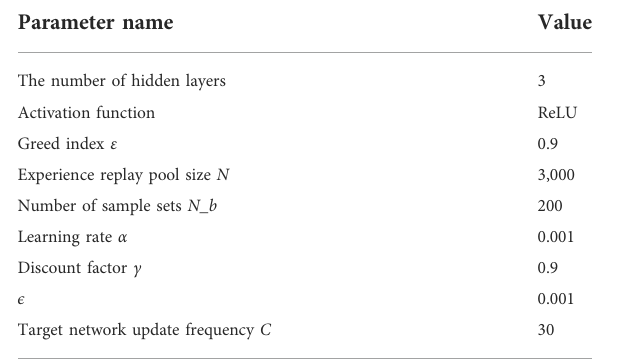
FIGURE 1 Training effect comparison